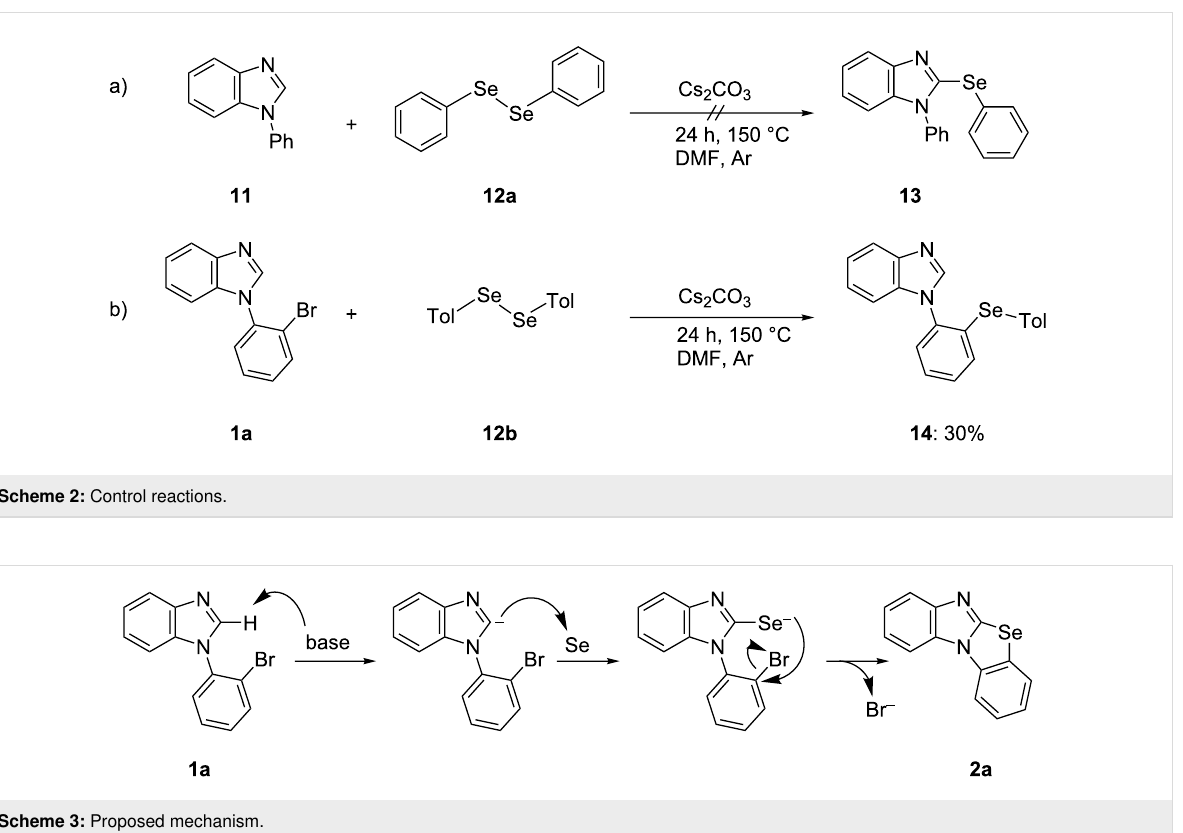
Cs 2 CO 3 -mediated C(Het)–S bond formations of a heteroazole such as imidazo[1,2- a ]pyridine, oxadiazole, and benzimidazole with diaryl disulfides without a transition metal catalyst